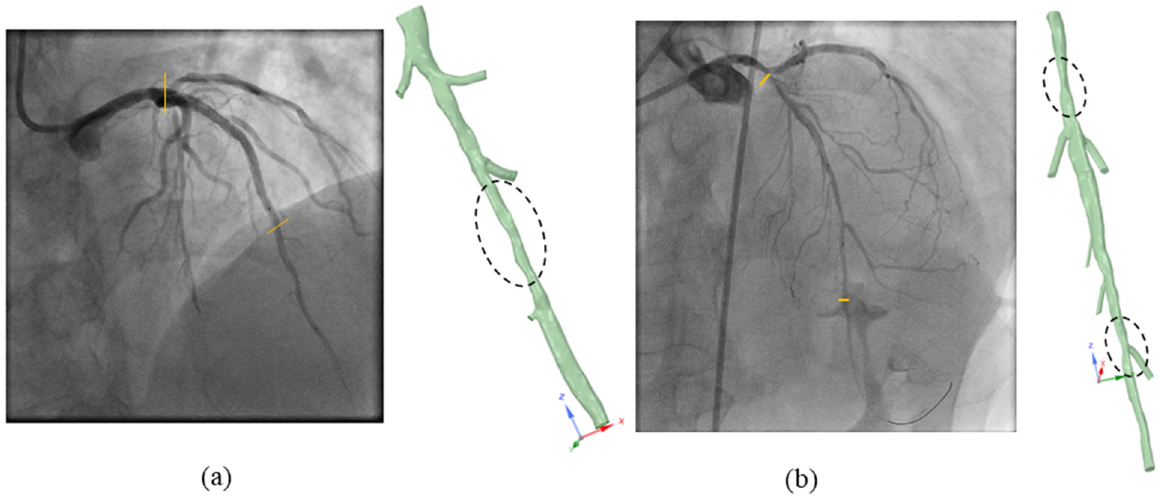
Figure 3. Reconstructed vessel tree models with corresponding angiography views of ( a ) patient 1 and ( b ) patient 2. Regions with significant stenosis are enclosed with dashed circles.